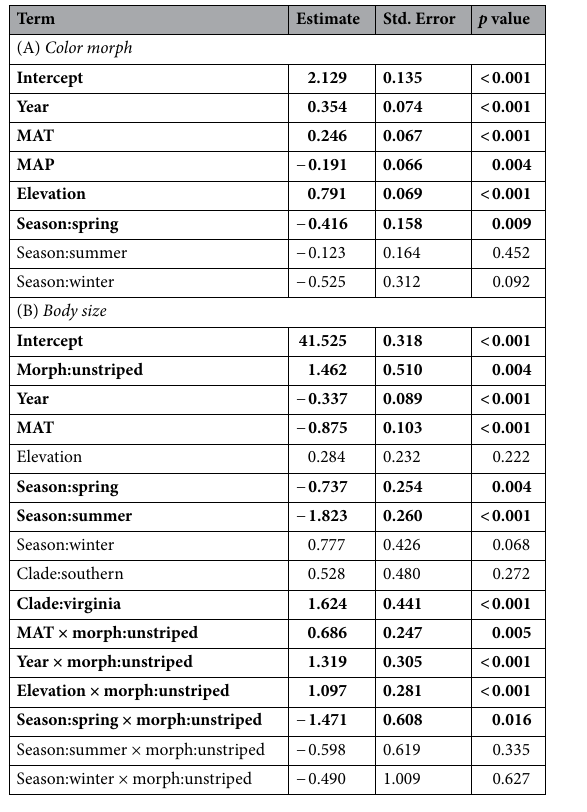
Table 1. Top (A) color morph frequency and (B) body size (SVL) model results. Bold effects are